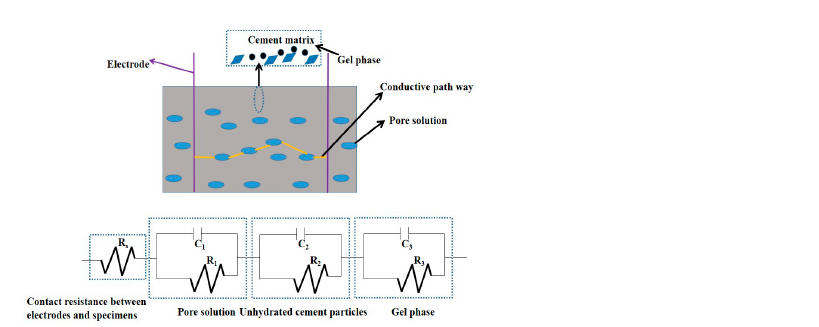
Figure 7. EIS curves of cement paste with different dosages of waste fly ash. ( a ) 1 d, ( b ) 28 d.